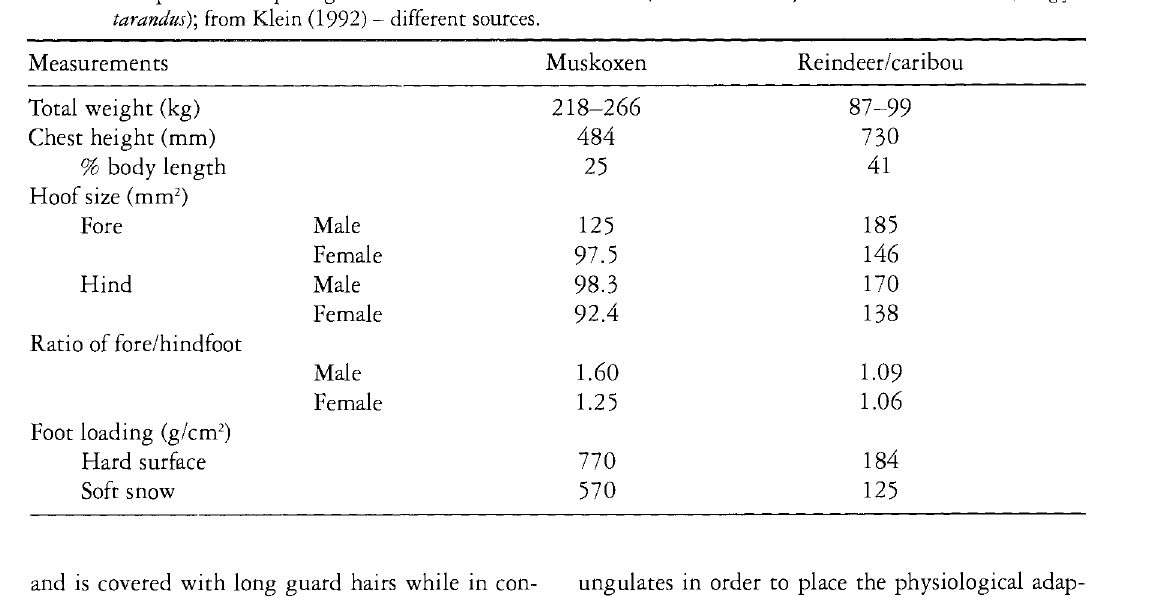
Table 1. Comparative morphological measurements of muskoxen {Ovibos moschatus) and reindeer/caribou {Rangifer tarandus); from Klein (1992) - different